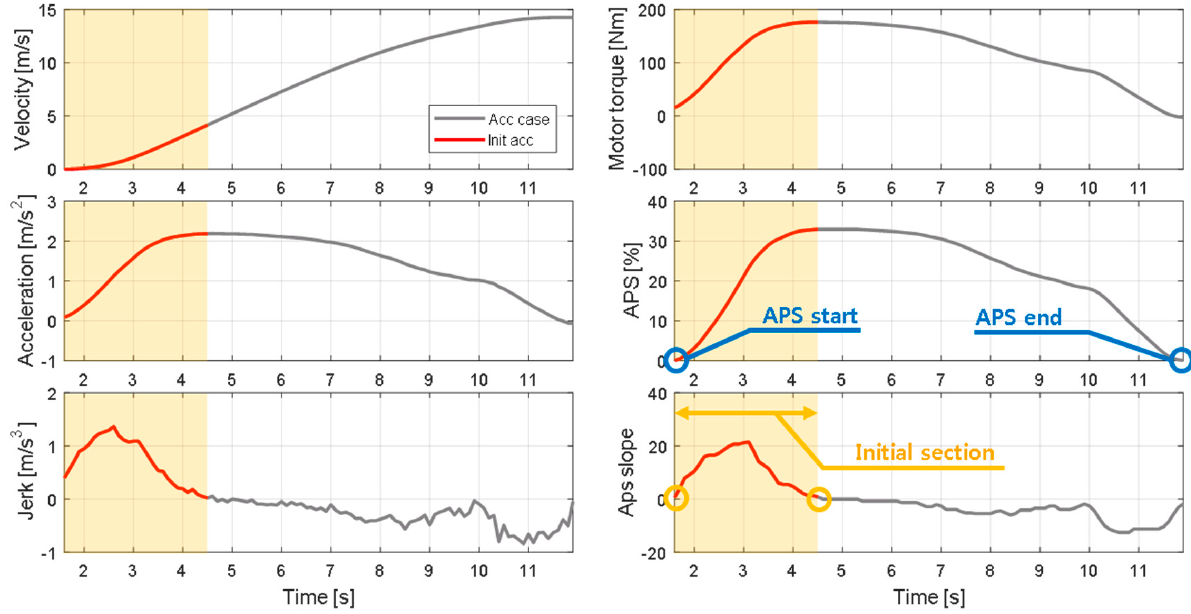
Figure 5. Definition of the initial acceleration section.